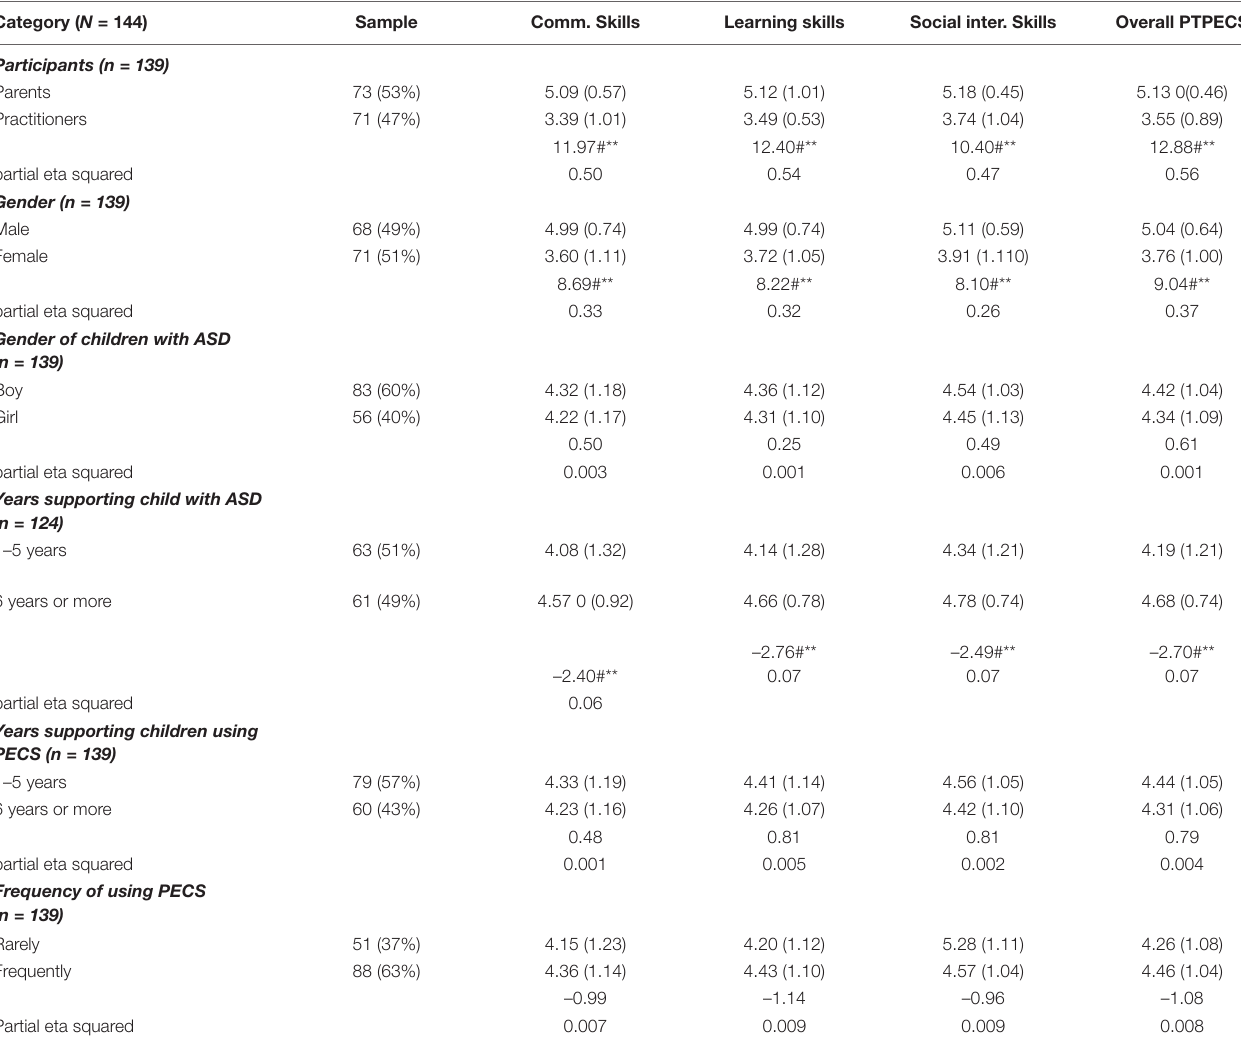
TABLE 1 | Summary of the association between two-level demographics and